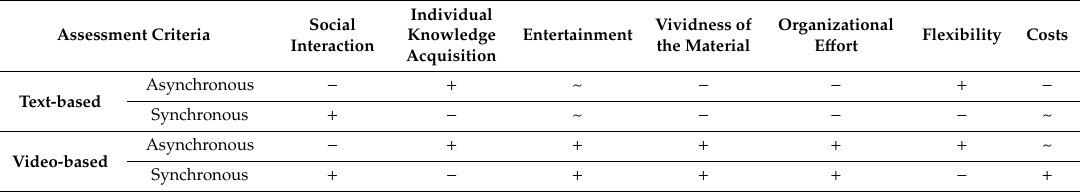
Table 1. Comparison of synchronous and asynchronous text- and video-based teaching